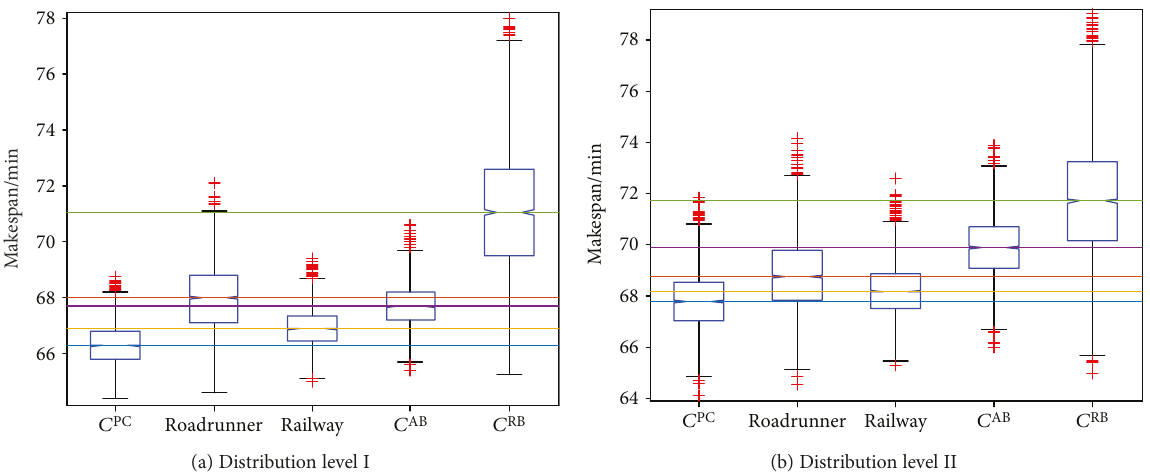
Figure 16: Boxplot of makespan with di ff erent scheduling policies.